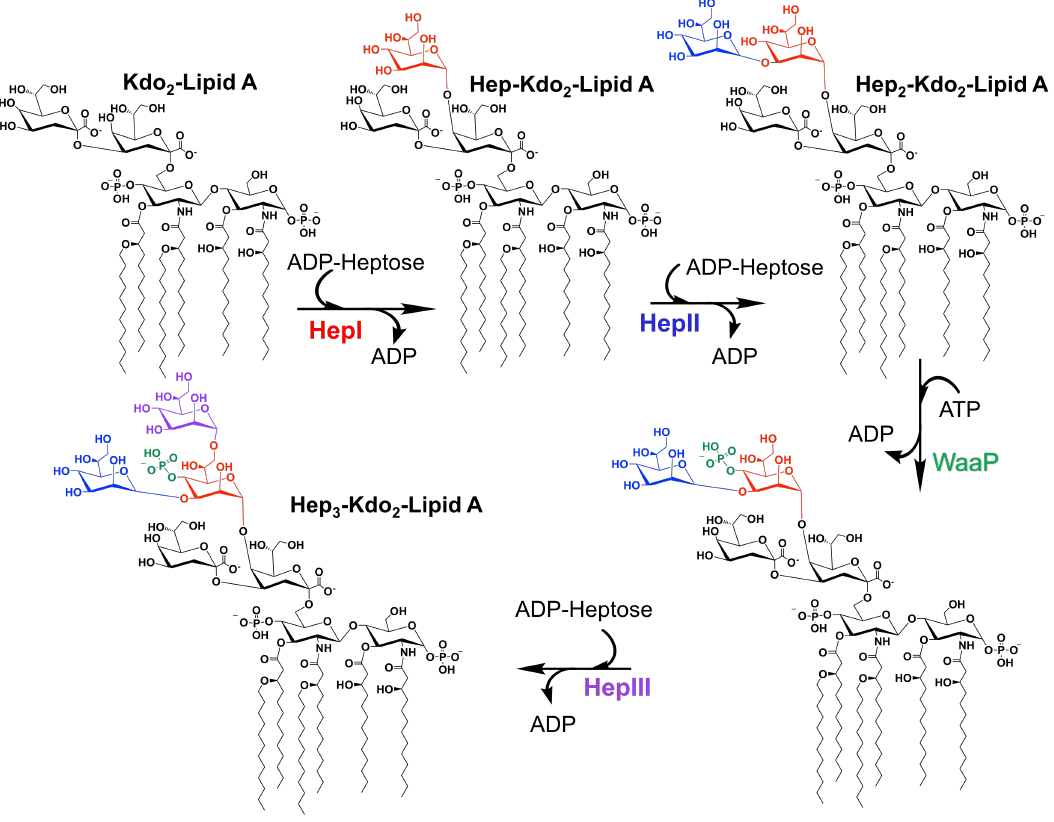
Figure 4. The sequential addition of three heptose moieties from ADPH catalyzed by Heptosytransferase I, II, and III (HepI, II, and III, respectively). Each moiety is color coded to match the enzyme that catalyzed the addition (red, blue, purple for HepI, II, and III, respectively). Prior to addition of the third heptose, WaaP phosphorylates the first heptose [46]. 3.1. Multiple Sequence Alignment (MSA) of Heptosyltransferase Enzymes Gram-negative bacteria have up to four heptosyltransferases; HepI and HepII are always